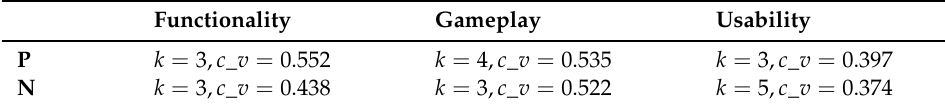
Table 6. Best fitting topic numbers and c_v values.